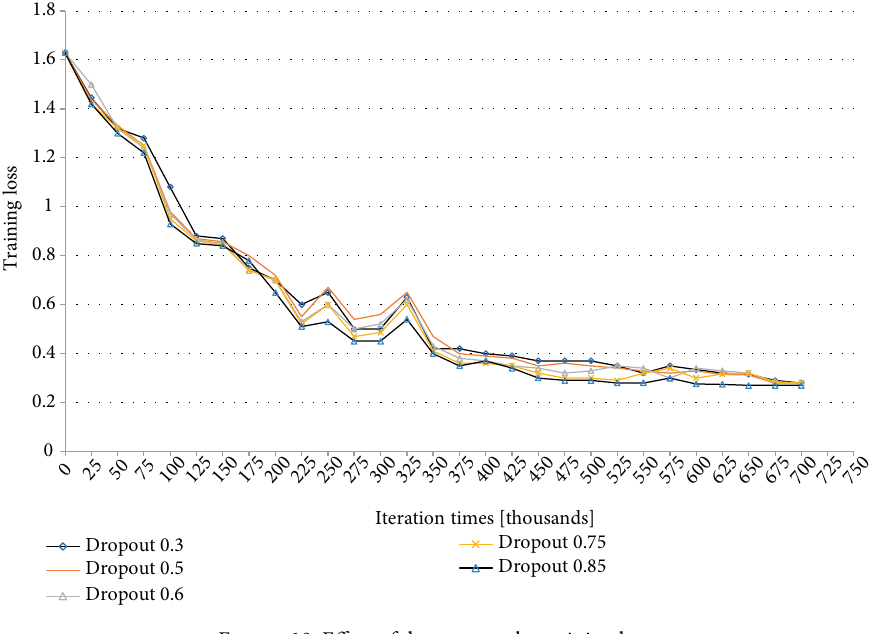
Figure 18: Effect of dropout on the training